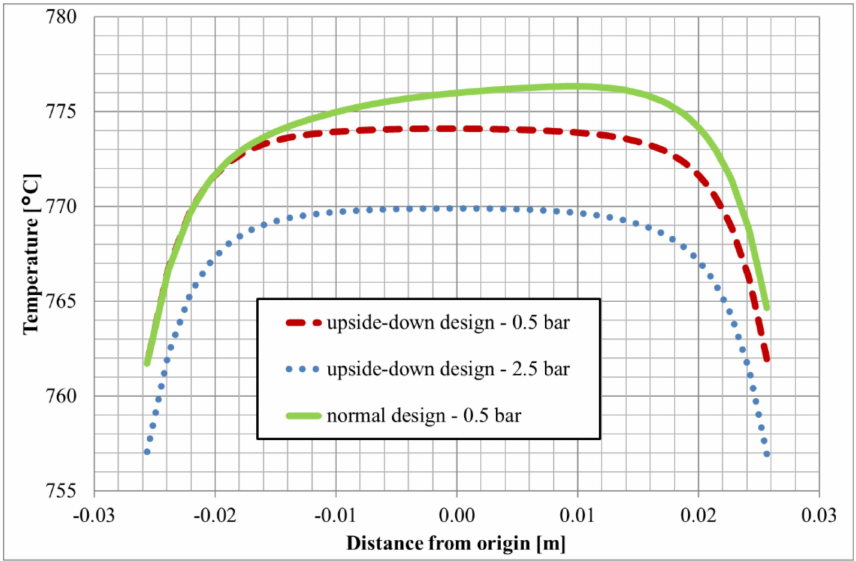
Figure 8. The temperature distribution along the substrate surface diameter for the upside-down and normal designs, at pressure levels of 0.5 bar and 2.5